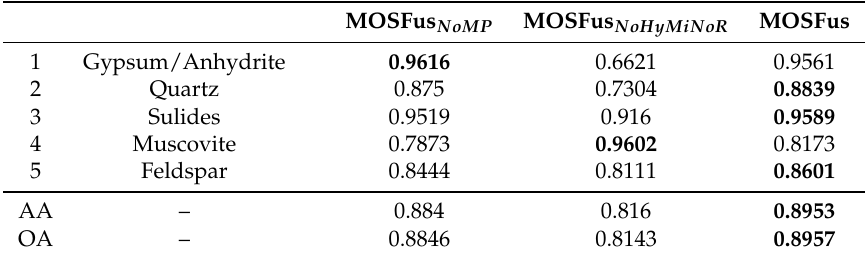
Table 6. The effects of HyMiNoR and morphological profile (MP) on the classification accuracies for the TS4 dataset. The highest accuracy in each row is shown in bold.